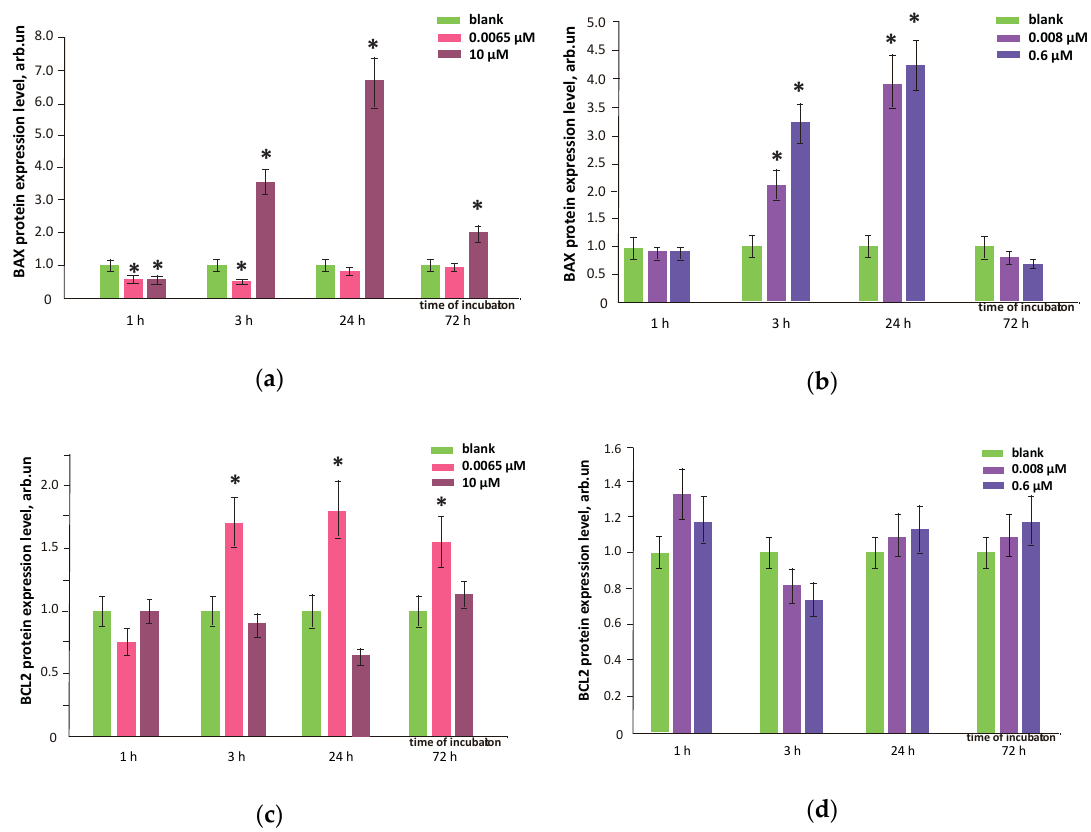
Figure 14. BAX and BCL2 proteins levels in HFLF culture treated with ( a , c ) FF1 and ( b , d ) FF2 (concentrations are shown in figure) relative to blank (cells with no fullerenes added). (*)— significant differences relate to blank, p < 0.01, nonparametric U- test. In blank experiments, cells were incubated without the fullerenes.